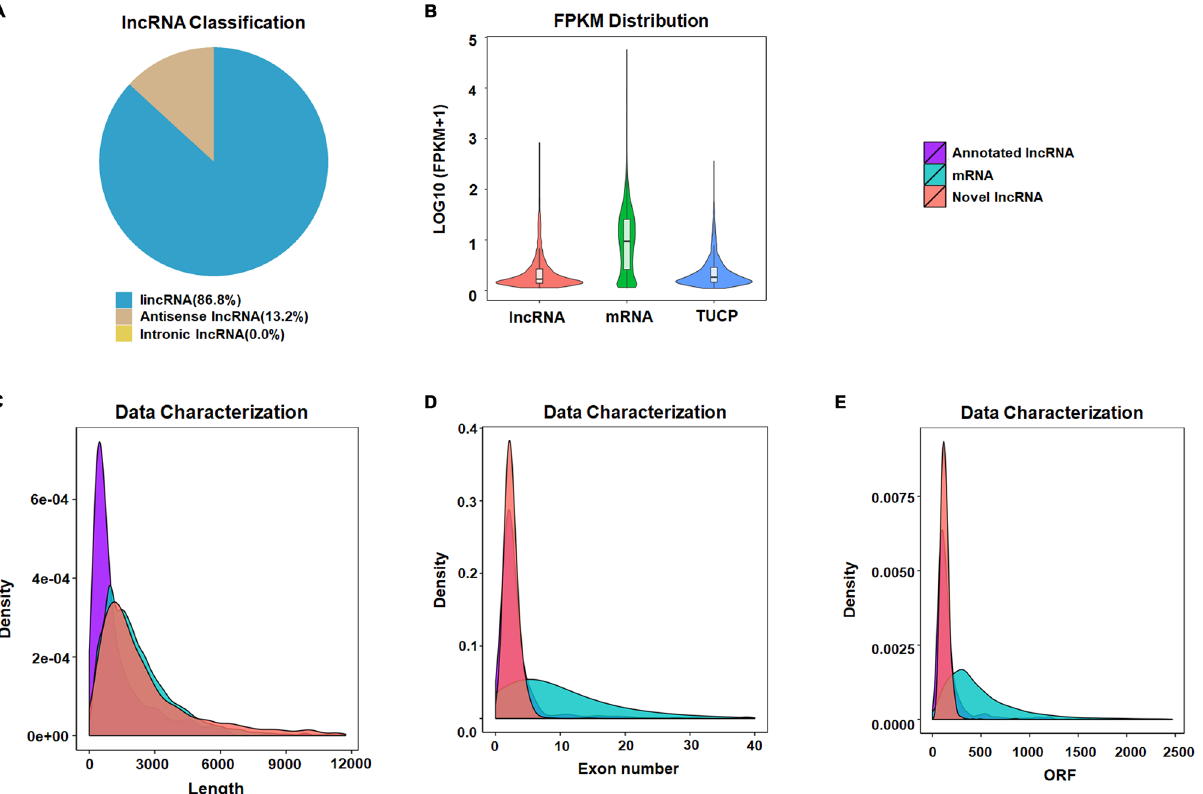
Figure 2. Genomic characterization of lncRNAs in PC12 cell lines. ( A ) A pie chart illustrating the classification of lncRNAs derived from PC12; ( B ) Expression level distribution of lncRNAs and mRNAs derived from PC12 cells; ( C ) Representation of the transcript length distribution derived from PC12 cells; ( D ) Exon numbers of transcripts derived from PC12 cells; ( E ) Open reading frame (ORF) of transcripts derived from PC12 cells.